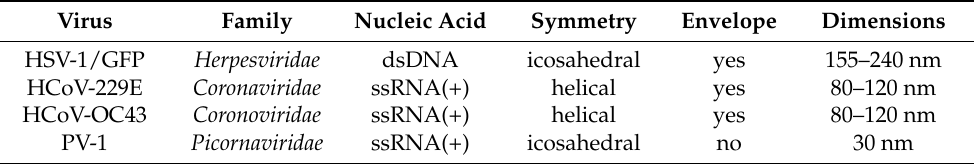
Table 6. Main characteristics of the viruses utilized in this